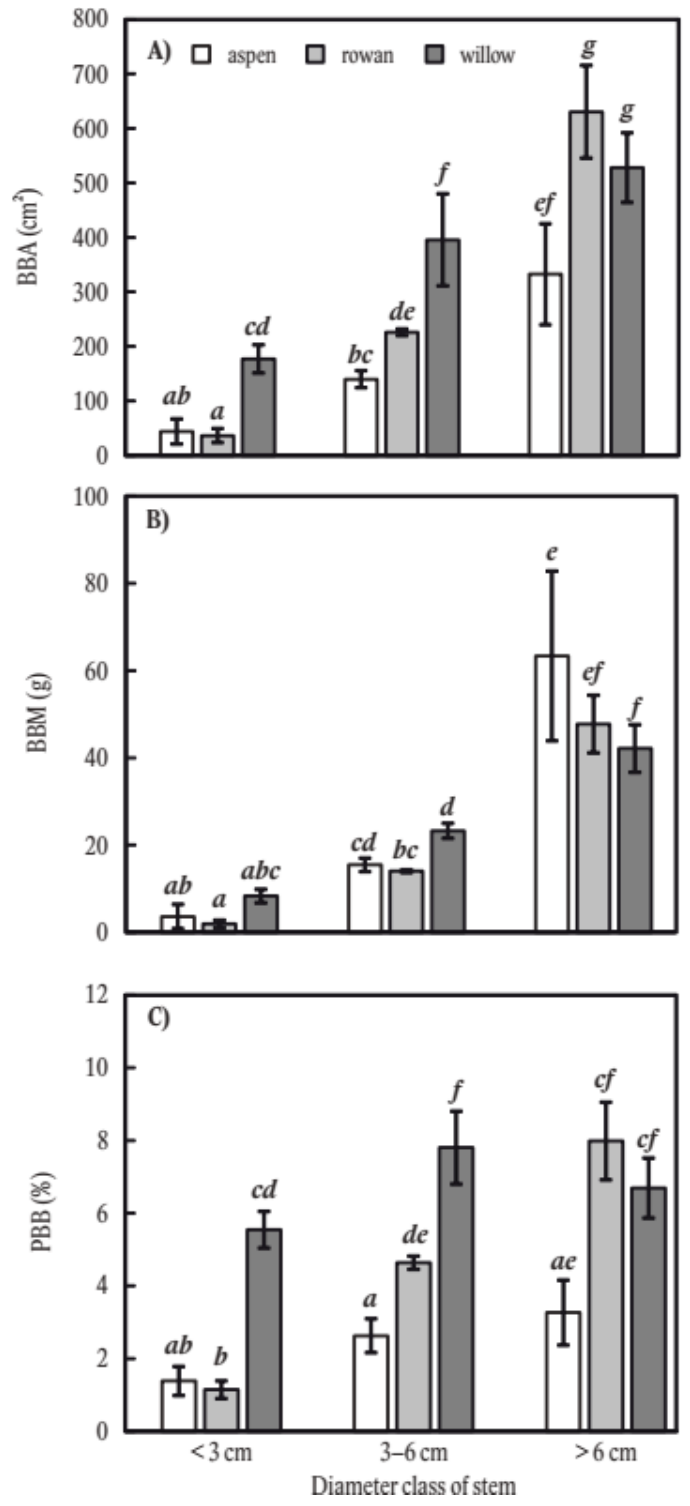
Figure 2. Stem bark browsing on common aspen ( Populus tremula L.), common rowan ( Sorbus aucuparia L.), and goat willow ( Salix caprea L.) considering diameter classes of stems. The stem browsing is expressed on the basis of area ( A ), mass ( B ), and the proportion of browsed bark mass to full bark mass potential ( C ). The error bars indicate standard errors. The different letters above the error bars indicate significant differences (three-way ANOVA and LSD test with alpha-level of 0.05).